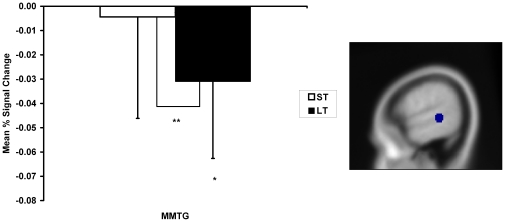
Region of interest analysis.Figure displays the a priori defined region of interest (the mid-portion of the middle temporal gyrus), within which significant differences in activation (p<0.05) were identified for two key contrasts. Bar graph indicates relative mean percentage BOLD signal change as a function of facilitation, compared to the unfacilitated condition. * indicates significant changes in mean signal intensity compared to the unfacilitated baseline (p<0.05) and ** indicates a significant difference between long-term (LT) and short-term (ST) facilitated conditions. Error bars indicate standard error mean.